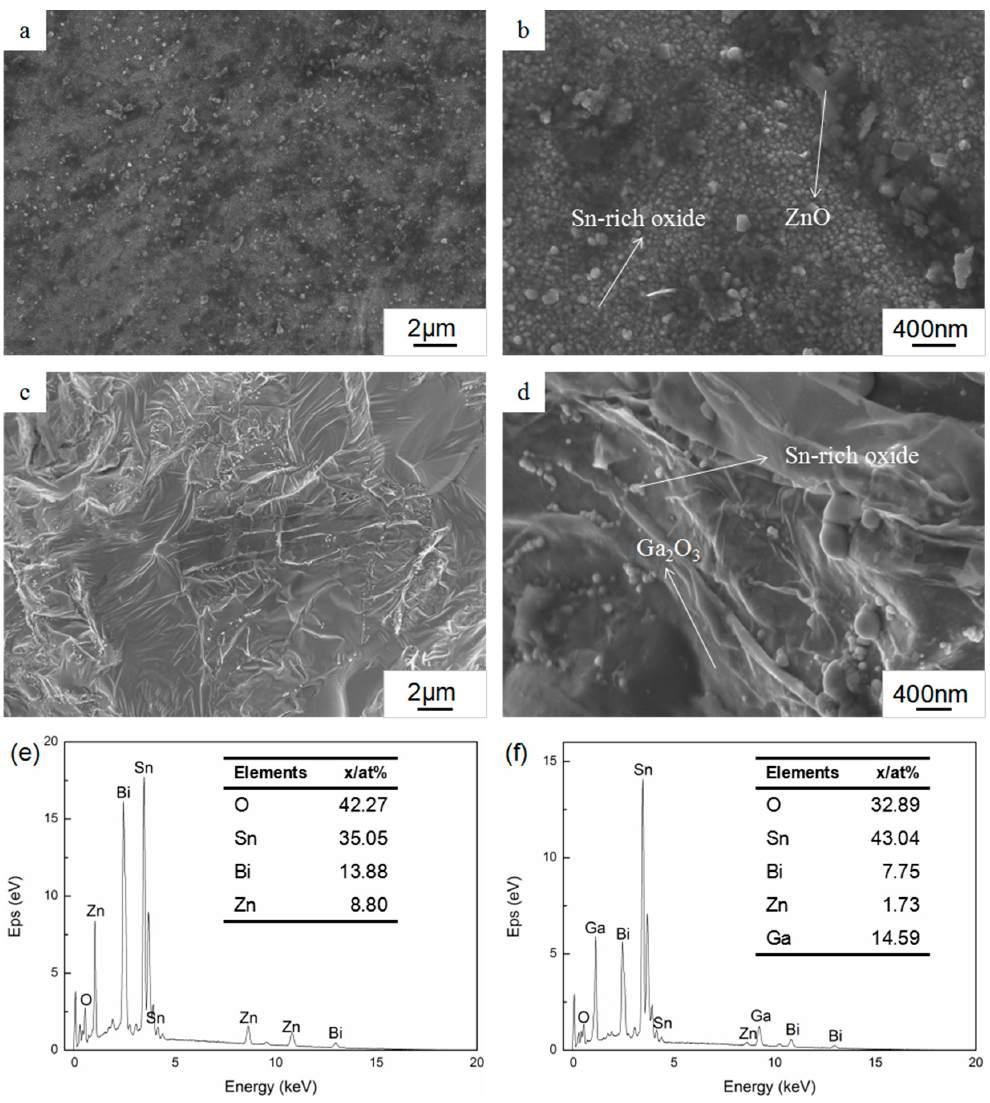
Figure 2. SEM images of surface morphologies of oxidation films of ( a , b ) Sn–50Bi–2Zn, ( c , d ) (Sn– Figure2. SEMimagesofsurfacemorphologiesofoxidationfilmsof( a , b )Sn–50Bi–2Zn,( c , d )(Sn–50Bi–2Zn)–7Ga, 50Bi–2Zn)–7Ga, and ( e , f ) EDS analysis of the oxide film. and ( e , f ) EDS analysis of the oxide